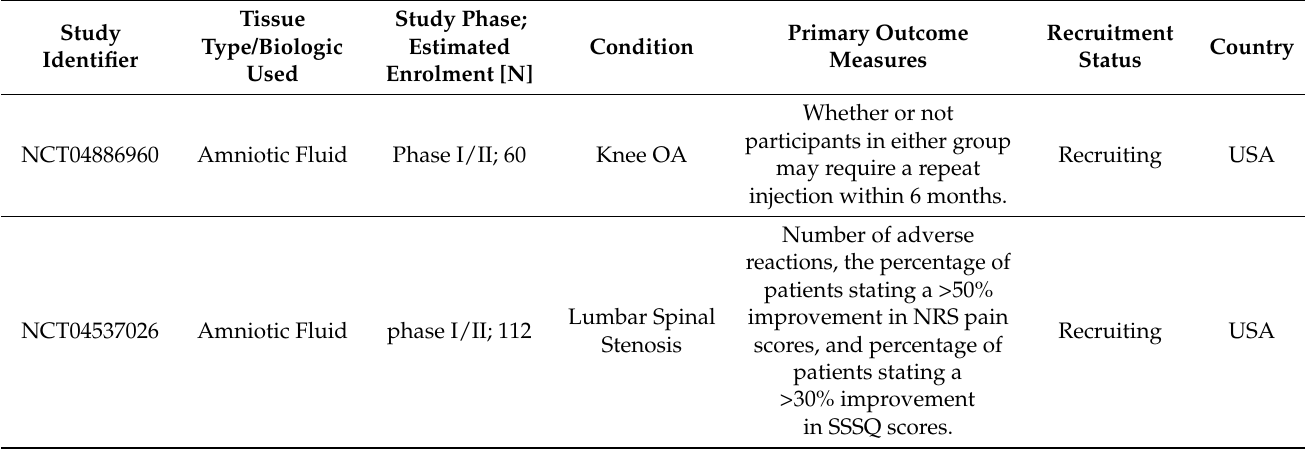
Table 4. Clinical trials registered on ClinicalTrials.gov till 10 October 2022 utilizing amniotic fluid cells for the treatment of orthopedic